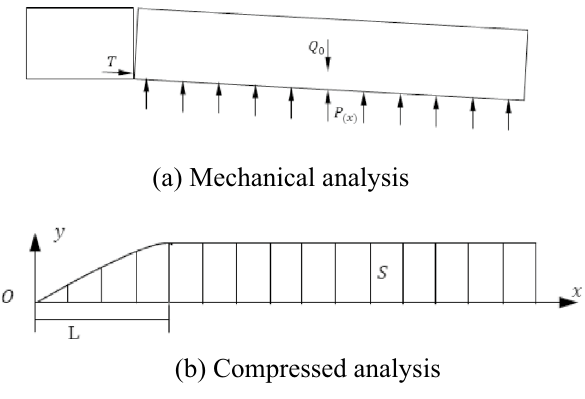
Fig. 4 Mechanical and compressed analyses of an elastic beam under large periodic